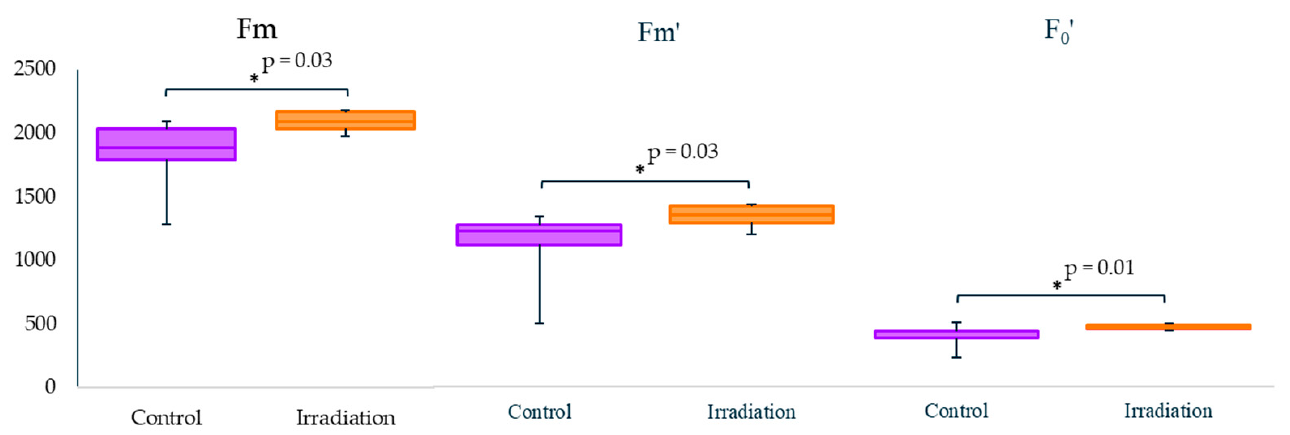
Figure 5. Chlorophyll fluorescence of juvenile Bab-0 plants, measured on the 17th day of cultivation in three plants per replicate for three biological replicates. “Control”—plants grown from untreated Bab-0 (Background) seeds; “Irradiation”—plants grown from seeds exposed to acute γ -radiation at a dose of 150 Gy, Bab-0 (Acute HD). Significant differences with exact p -values (Mann–Whitney U -test) are denoted by asterisk. The graphs were created using RStudio v1.4 (R-Tools Technology, Richmond Hill, ON, Canada).